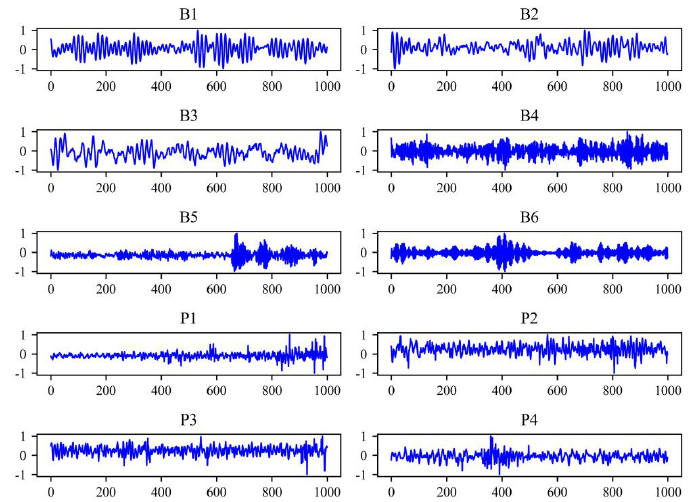
Figure 6. Example signals of CWRU and Paderborn dataset. B1 to B6 are the working conditions of CWRU dataset. P1 to P4 are the working conditions of Paderborn